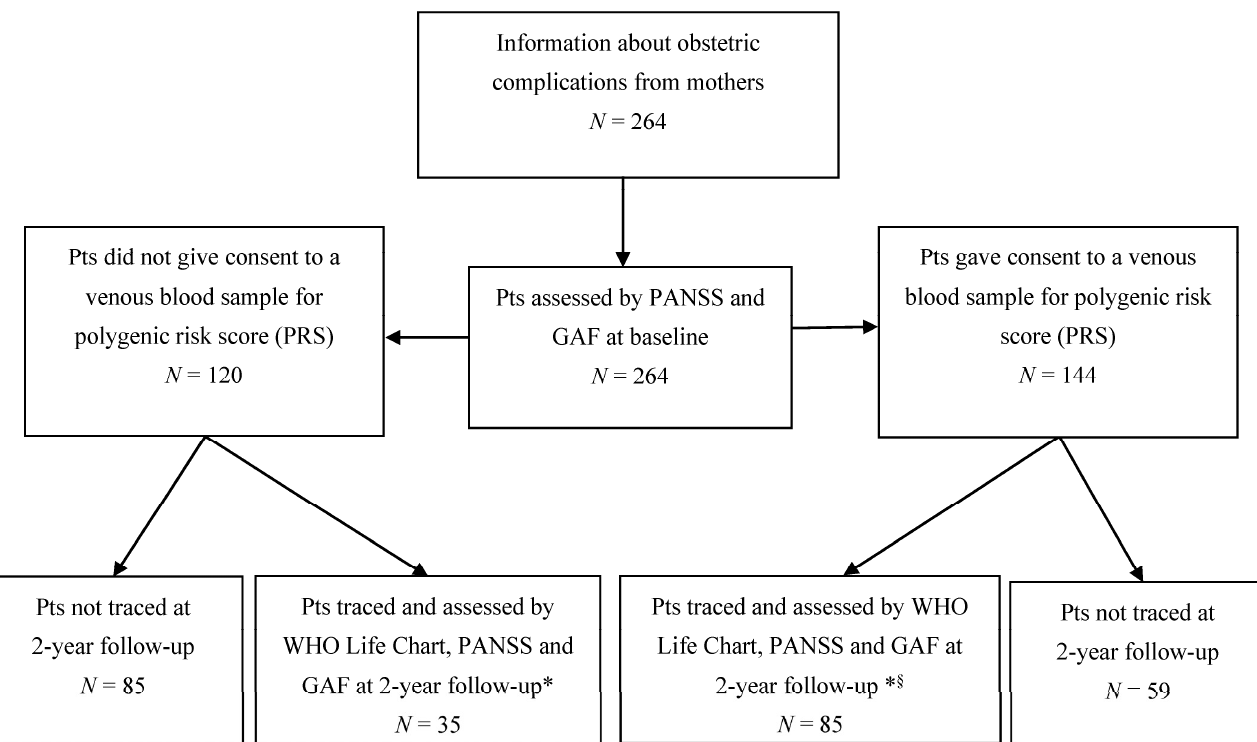
Figure 1. Flow-chart of assessments for the sample ( N = 264). * n = 120 patients with PANSS and GAF at both baseline and 2-year follow-up and with WHO Life Chart at 2-year follow-up (sample for clinical assessments). § n = 85 patients with clinical assessments and polygenic risk score (sample for